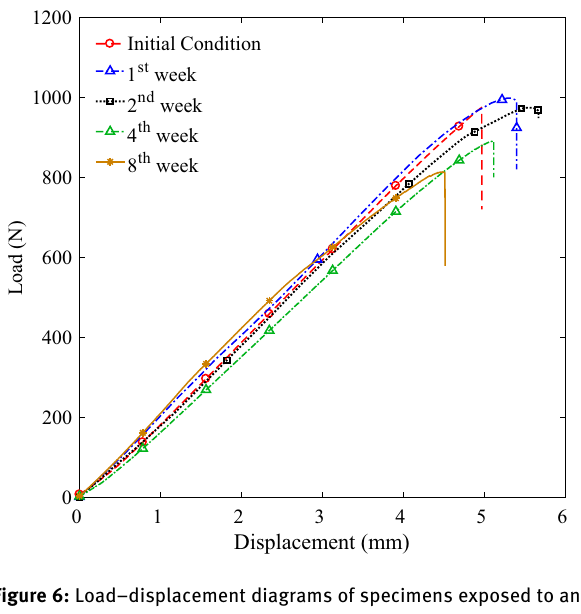
Figure 6: Load – displacement diagrams of specimens exposed to an acidic environment at 25°C.